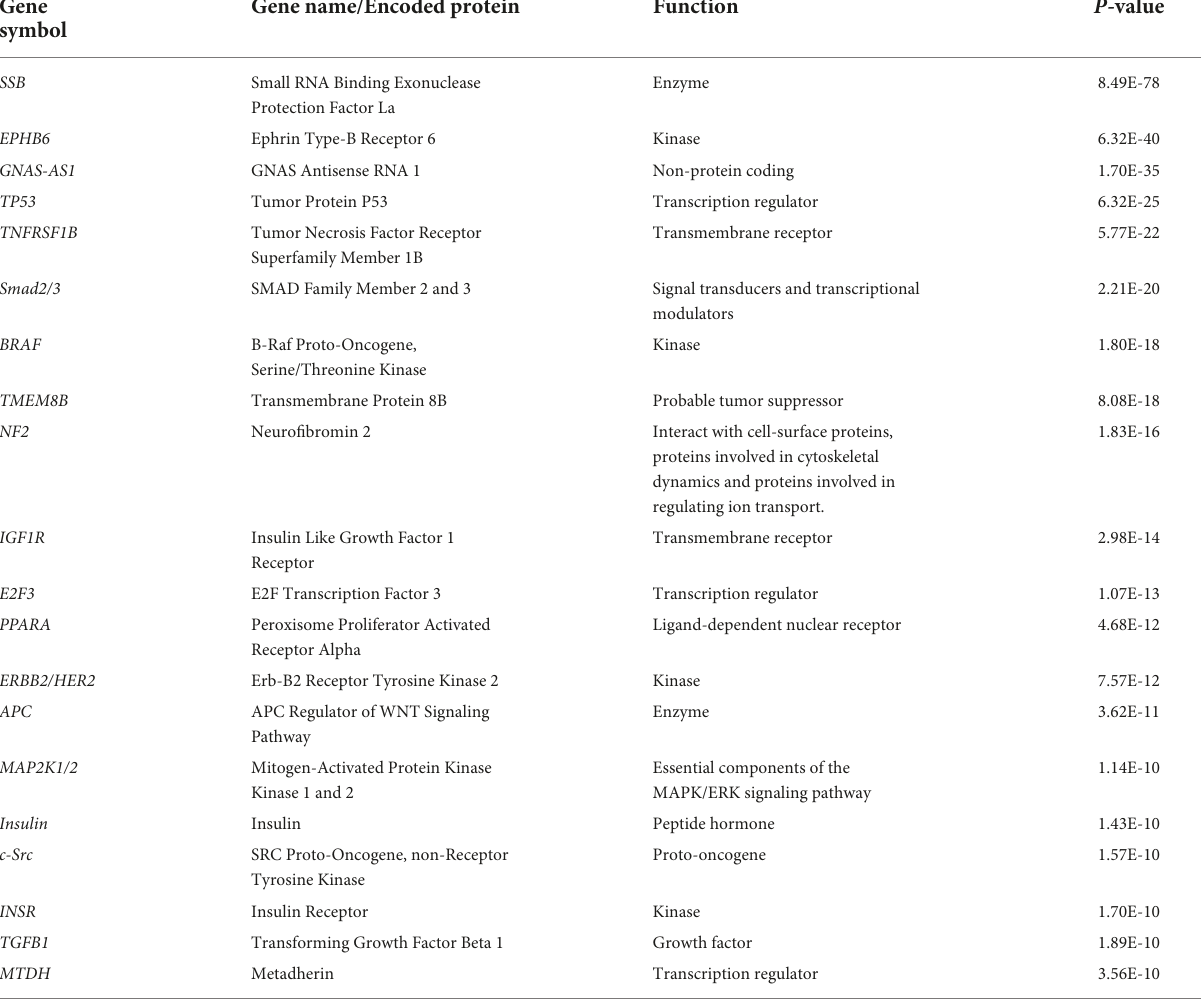
TABLE 2 Top 20 upstream regulators of the 123 highly expressed miRNAs in human term healthy